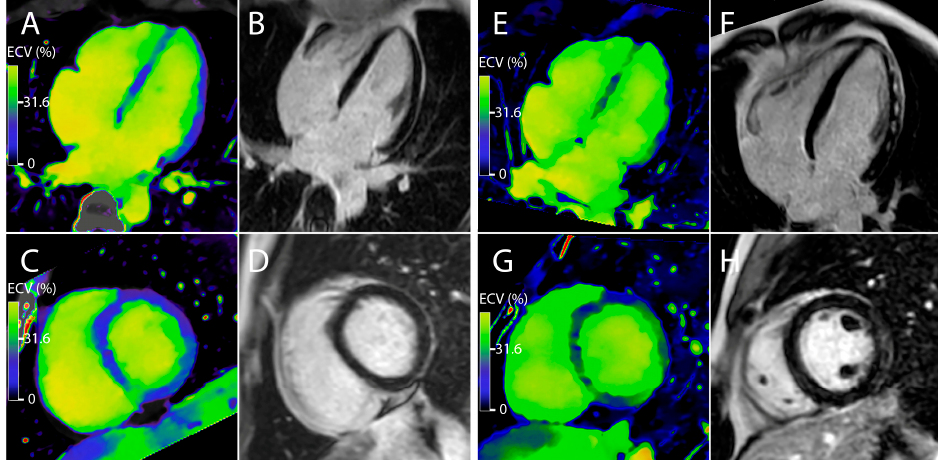
Figure 4. Representative cases of patients with suspected acute myocarditis. Left panel ( A – D ). Case of a 42-year-old woman with elevated high-sensitivity troponins at 83 ng/L at admission. A late phase DECT was performed at admission. The global ECV was measured at 29.7%. MRI did not show any late gadolinium enhancement. Right panel ( E – H ). Case of a 27-year-old man with elevated high-sensitivity troponins at 8000 ng/L at admission. A late phase DECT was performed at admission. The global ECV was measured at 35.1%. MRI showed multiple late gadolinium enhancement of the sub-epicardial myocardial wall in favor of myocarditis.